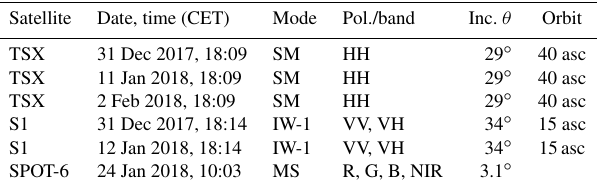
Figure 1. Red rectangle: area selected for avalanche mapping. Blue rectangle: subset used to visualize radar images and mapping re- sults (46 ◦ 51 (cid:48) N, 8 ◦ 34 (cid:48) E). Black rectangle in insets: full footprint of the TSX scene over Switzerland. © 2019 swisstopo (JD100042), reproduced with the authorization of swisstopo (JA100120). Table 1. Satellite images with local acquisition time (CET is UTC + 1). Acquisition modes are stripmap (SM), interferomet- ric wide-swath (IW), and single-pass multi-strip (MS) collection. S1 images used for the composite of Switzerland are listed in Ta- ble